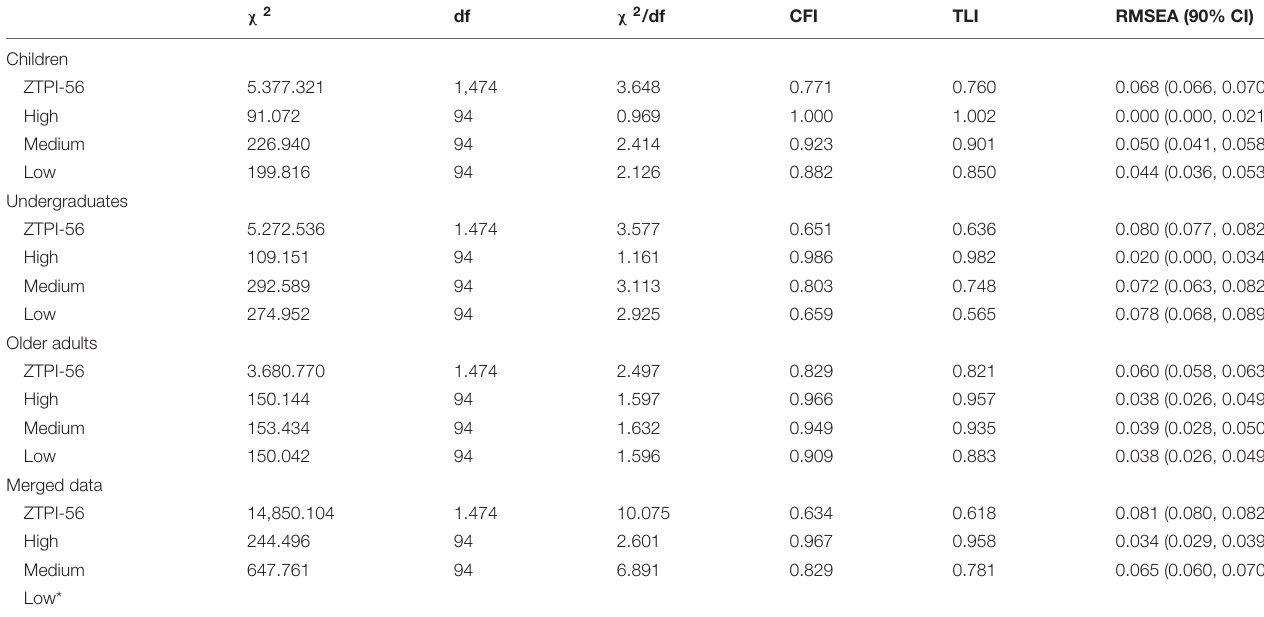
TABLE 2 | Fit indexes of CFA for ZTPI-56 and three short forms with high, medium, and low frequent items. χ 2 df χ 2 / df CFI TLI RMSEA (90% CI)